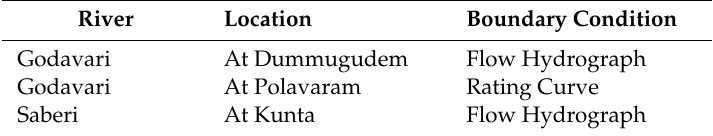
Table 3. Boundary conditions considered for 2D unsteady flow.